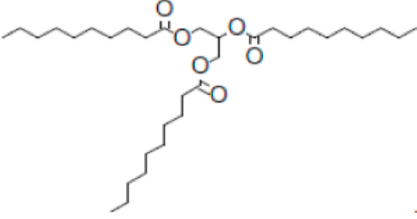
Figure 3. Chromatogram of n-butanol root extract of Saussurea lappa by GC–MS. Table 4. Compounds present in n-butanol root extract of Saussurea lappa analyzed by GC–MS. Sl No Retention Time